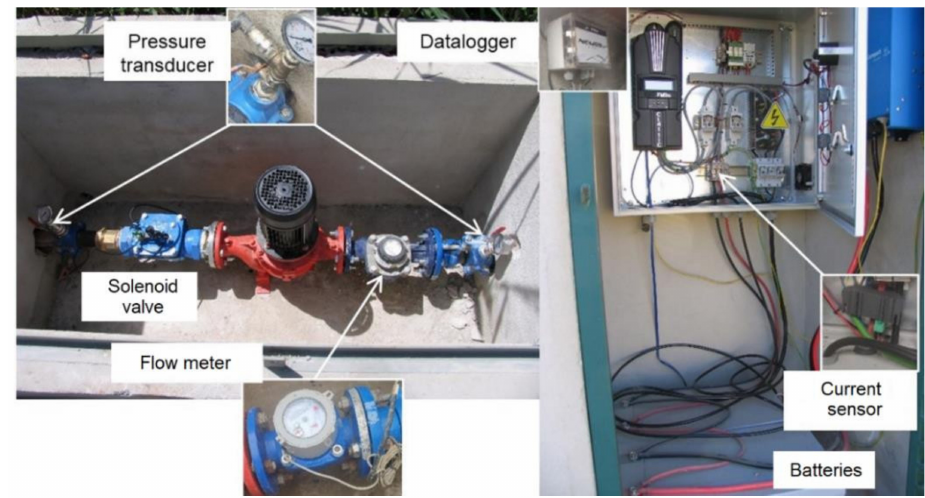
Figure 7. Detailed image of the components of the executed installation. ( Left ) The sequence of the ERT, sensors and control elements. ( Right ) Components of the control panel, batteries and inverter. Table 1. Technical parameters and cost of the equipment used in the energy generator